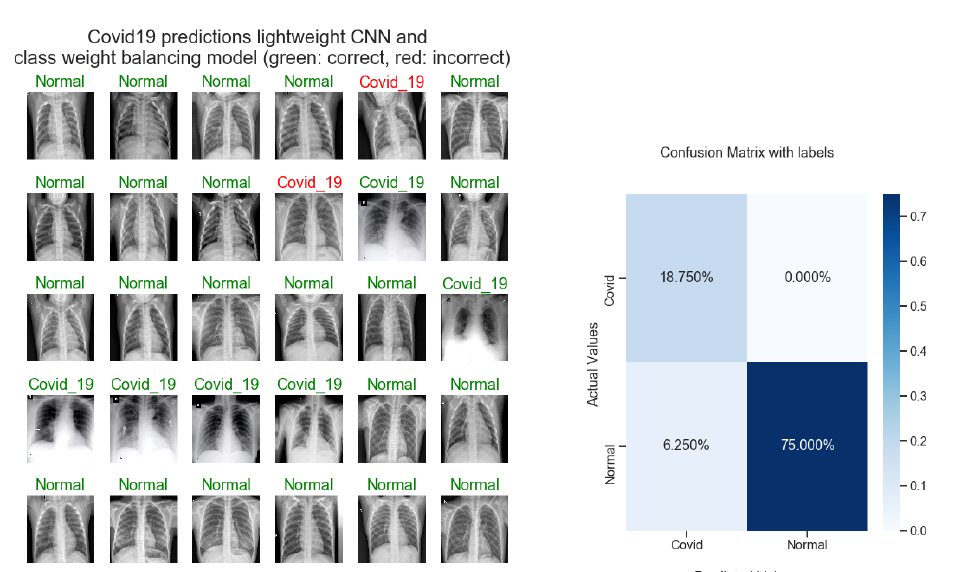
Figure 8. Model prediction best score.